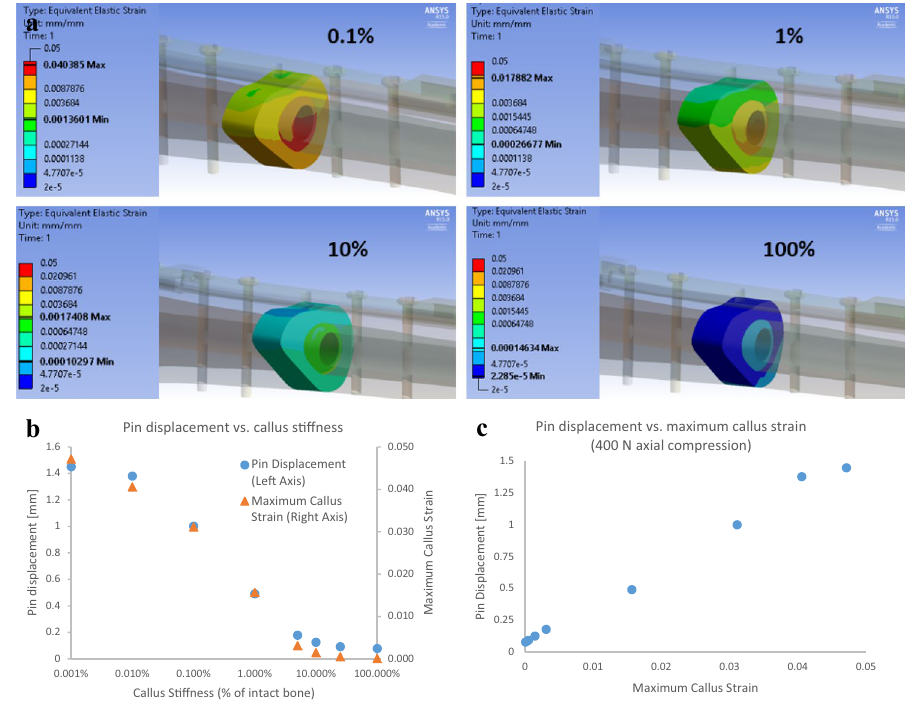
Figure 2. Fracture Callus FEA. ( a ) Strain distribution within the fracture callus for 400 N axial compression load with varying callus stiffness as a percent of cortical bone. ( b ) Pin displacement and maximum principal callus strain vs. callus stiffness. ( c ) Linear relationship between pin disp. and maximum callus principal